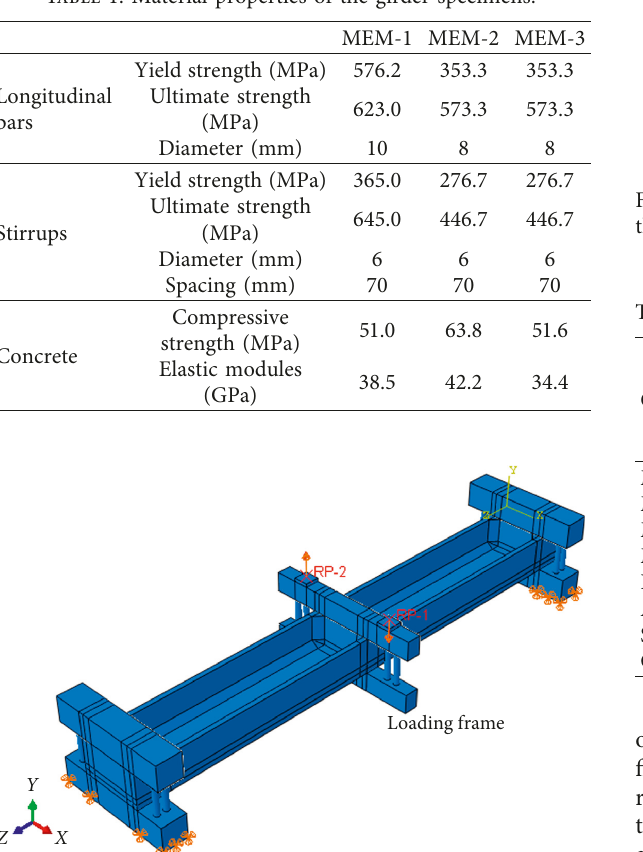
Figure 6: Detailed information of the U-shaped thin-walled RC girder specimens (unit: mm): (a) dimensions and (b) reinforcing arrangements. Table 1: Material properties of the girder specimens.